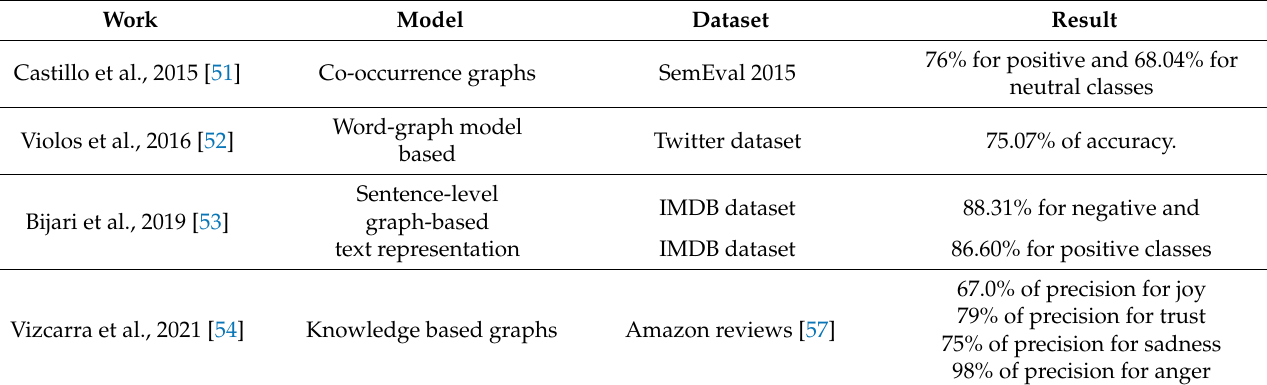
Table 2. Graph-based techniques for sentiment classification and